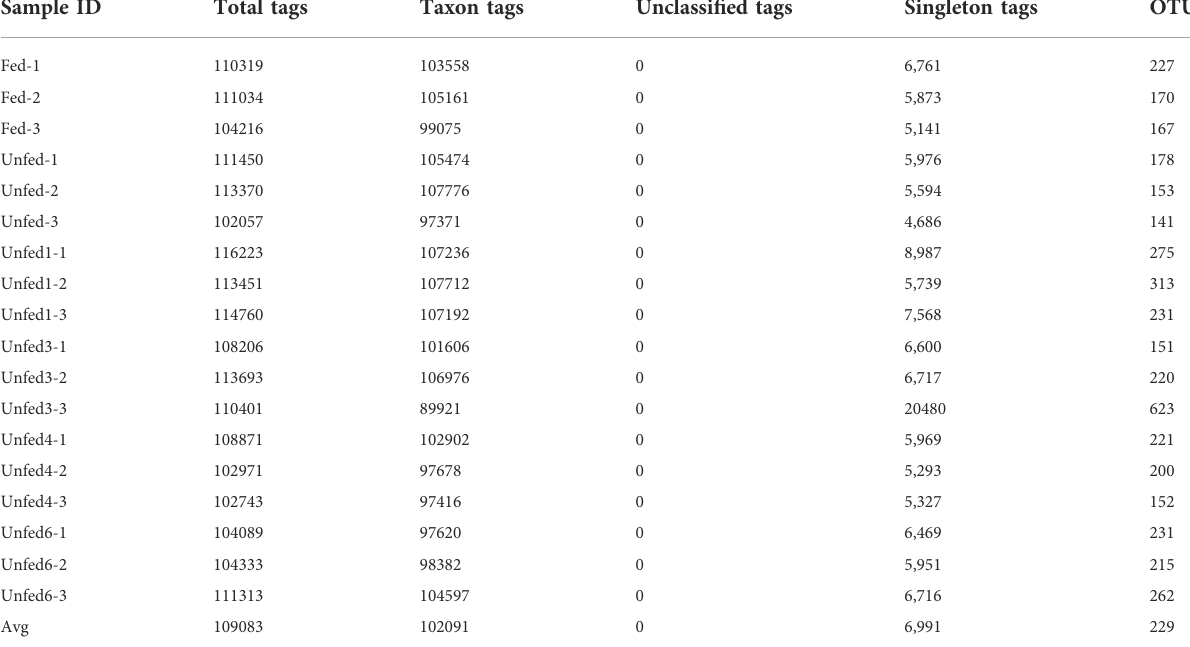
TABLE 1 Statistics of tags and